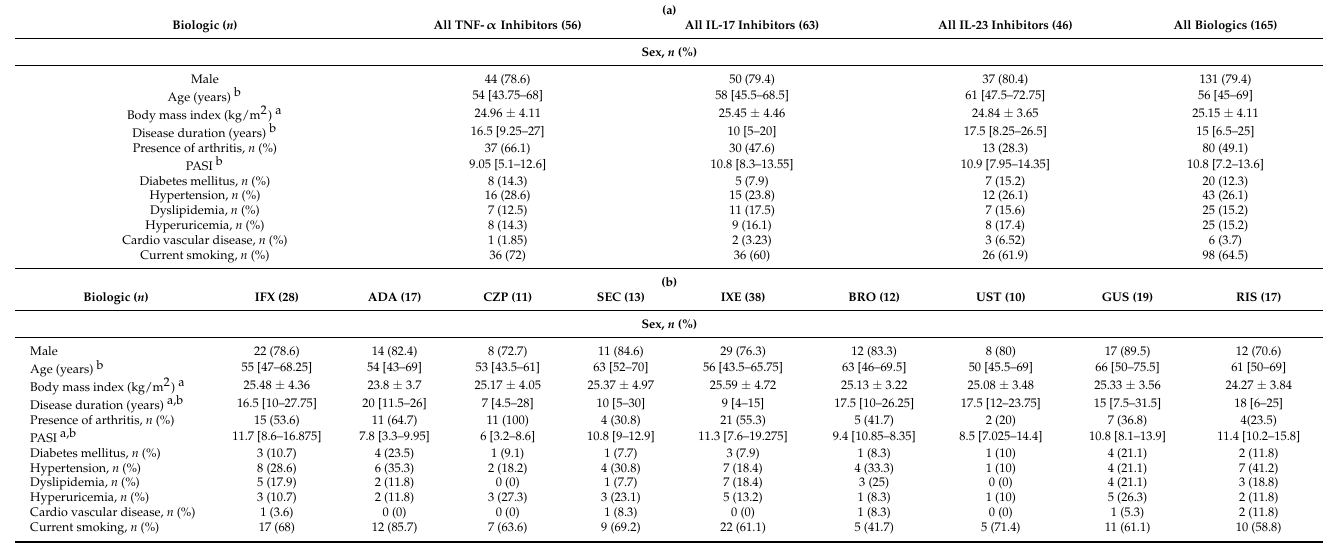
Table 1. (a) Baseline demographic and disease characteristics of patients with psoriasis in 3 groups of biologics; (b) Baseline demographic and disease characteristics of patients with psoriasis in each biologic.